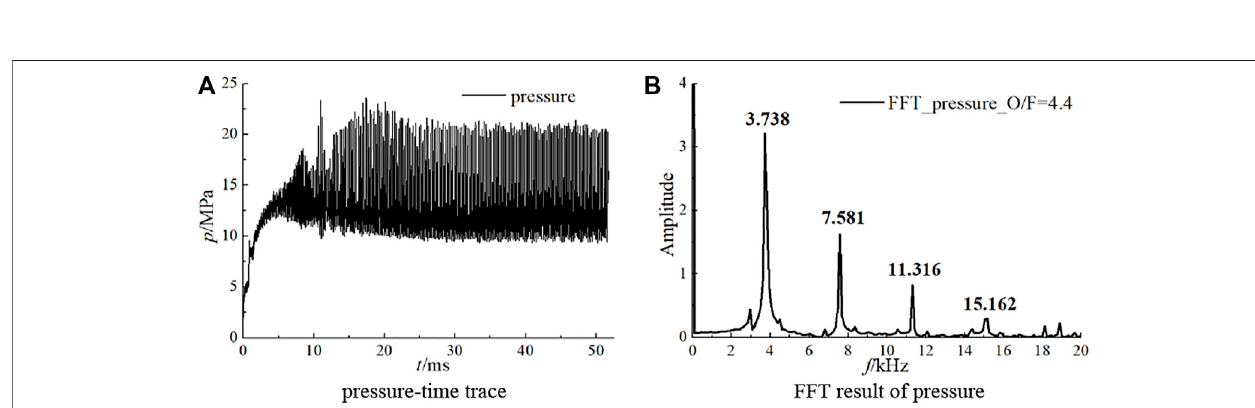
Frontiers in Energy Research |